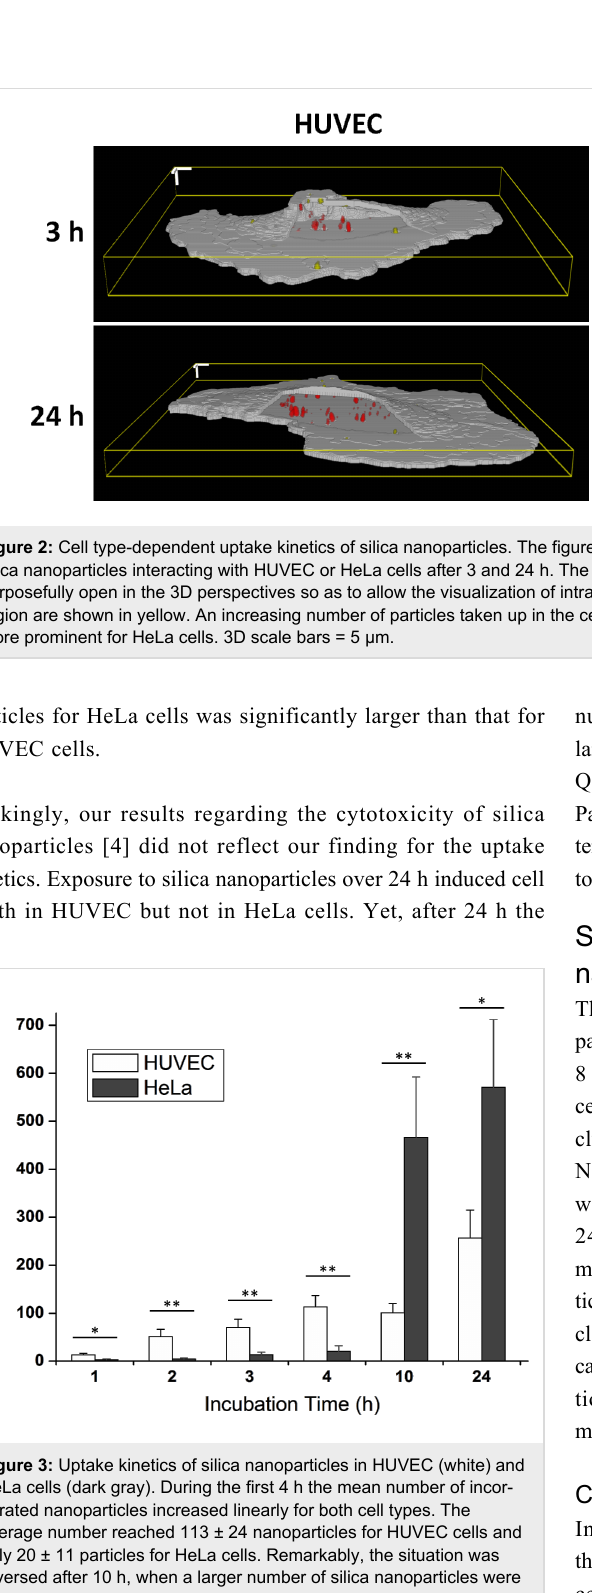
Figure 3: Uptake kinetics of silica nanoparticles in HUVEC (white) and HeLa cells (dark gray). During the first 4 h the mean number of incor- porated nanoparticles increased linearly for both cell types. The average number reached 113 ± 24 nanoparticles for HUVEC cells and only 20 ± 11 particles for HeLa cells. Remarkably, the situation was reversed after 10 h, when a larger number of silica nanoparticles were incorporated by HeLa cells. After 24 h, the mean value of taken up particles for HUVEC cells was 256 ± 58, while for HeLa it was 570 ± 141. The histograms show the mean ± standard error of the mean of at least three independent experiments ( n = 28–32). Results were statisti- cally different (* p < 0.05) for incubation times of 1 and 24 h and highly statistically different (** p < 0.01) for all other time points.